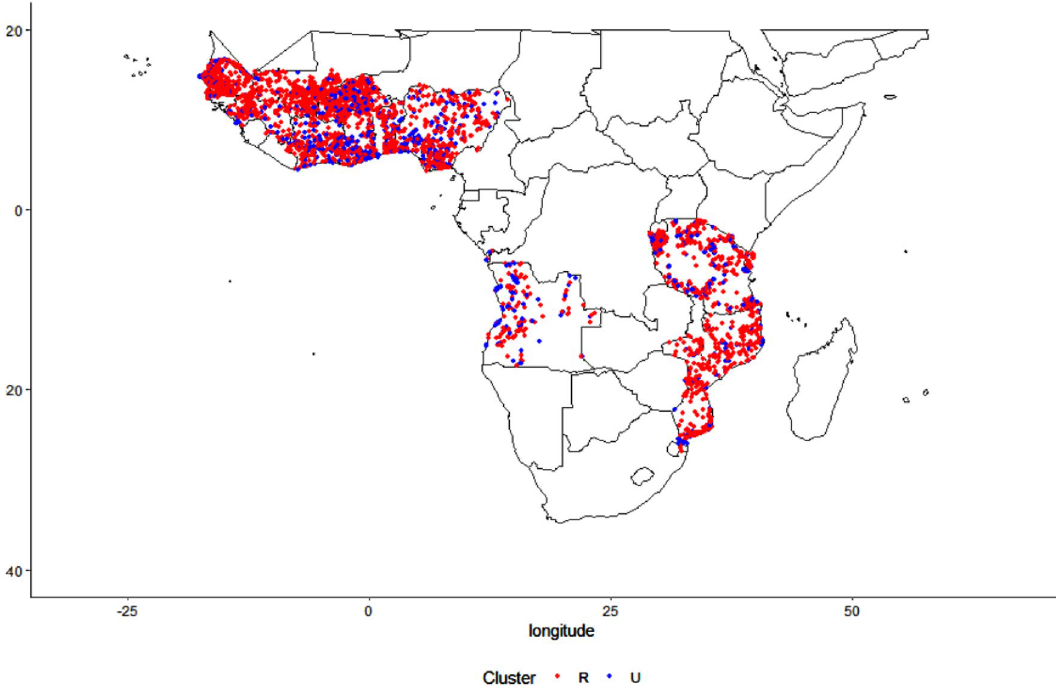
Figure 1. Location of household rural and urban clusters. Our georeferenced dataset includes 24,034 children in 14,281 households in 4028 clusters located in 12 countries between 2010 and 2015. The dataset links geo- referenced Demographic and Health Surveys (DHS) individual and household information with data on agricultural land uses, forest cover, forest loss and